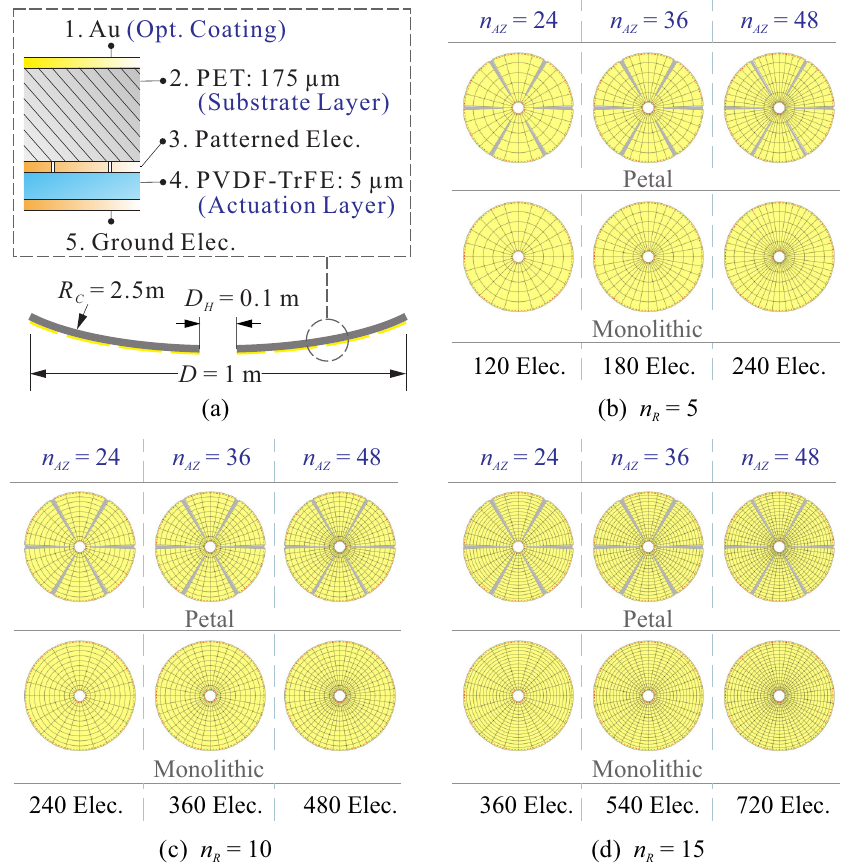
Figure 7. Numerical models for the configuration study of morphing capabilities: ( a ) the struc- tural parameters of the tested composite primary reflector; ( b – d ) electrode patterns of numerical examples with radial orders of n R = 5, 10, and 15 and azimuthal orders of n AZ = 12, 24, and 36. The performances of both monolithic (full) and petal-like (division order: m = 6) configurations are